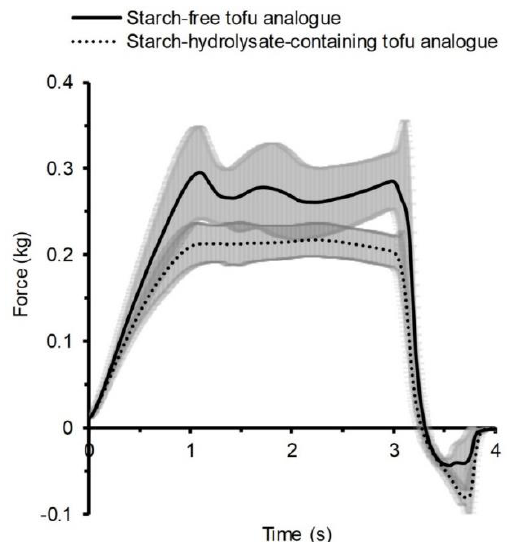
Figure 4. Textural properties of faba bean starch-free and starch-hydrolysate-containing tofu analogues measured by a compression test. The shaded areas show the standard deviation from six replicates.